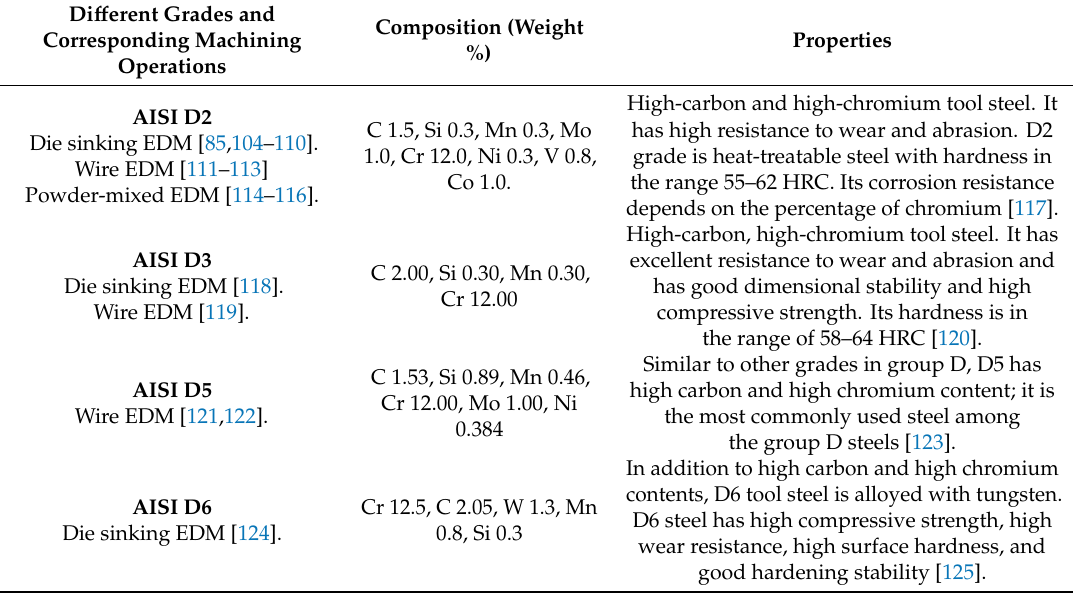
Table 1. Details of various EDM processes used by researchers for di ff erent grades of tool